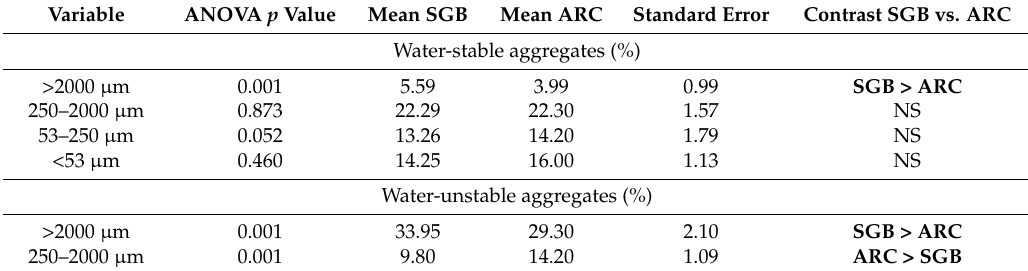
Table 1. ANOVA results from the comparison of the proportional of water-stable and water-unstable aggregates in each aggregate fraction from switchgrass buffer (SGB) and non-buffered annual row crop